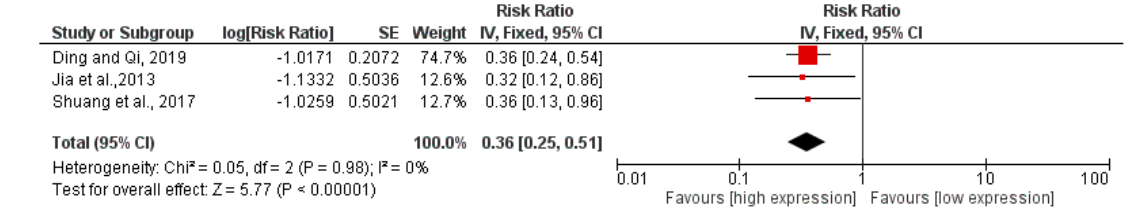
Figure 2. Forest plot of the fixed effects model of the meta-analysis; OS, RR = 0.36 95% CI: [0.25, 0.51]; df = degrees of freedom; I 2 = Higgins heterogeneity index, I 2 < 50%, heterogeneity irrelevant; I 2 > 75%, significant heterogeneity; CI = confidence intervals; p = p -value; SE = standard error. The graph of each study shows the first author and publication date, log RR with confidence intervals, standard error log RR, and weight of each study expressed as a percentage. The final value is expressed in bold with the relative confidence intervals. The black line shows the position of the average value, and the light black diamond shows the measure of the average effect